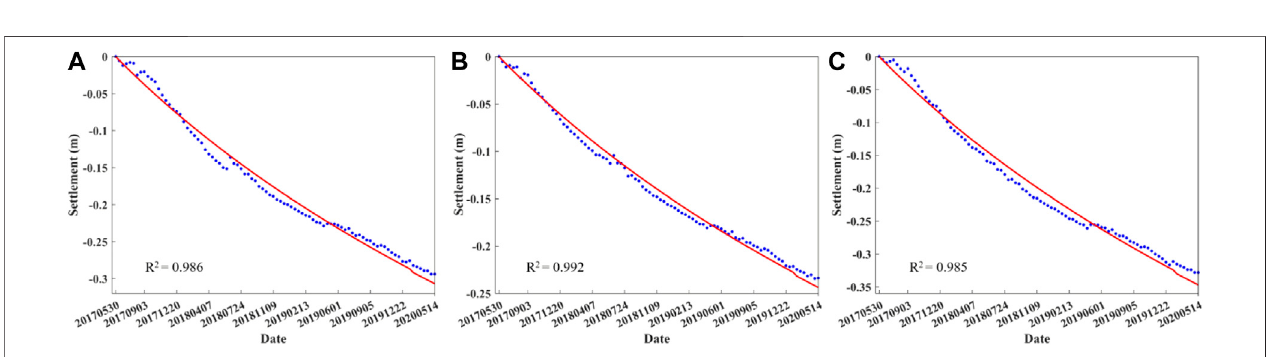
FIGURE 5 | (A – C) : Time-series settlement at the points P1-P3 whose locations are marked by black triangles in Figure 4 .